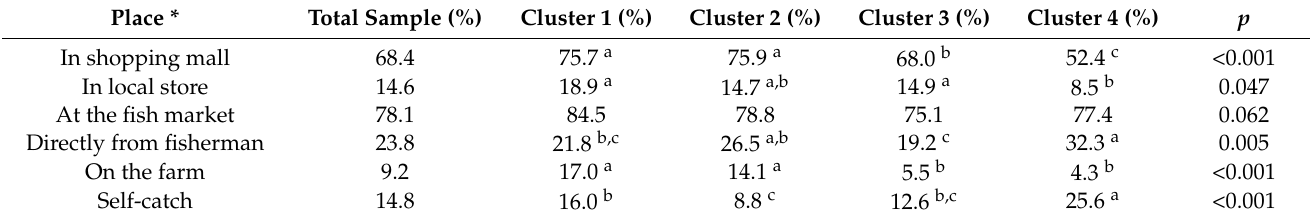
Table 7. Place of usual purchase of fishery products of Croatian fishery consumers (n =